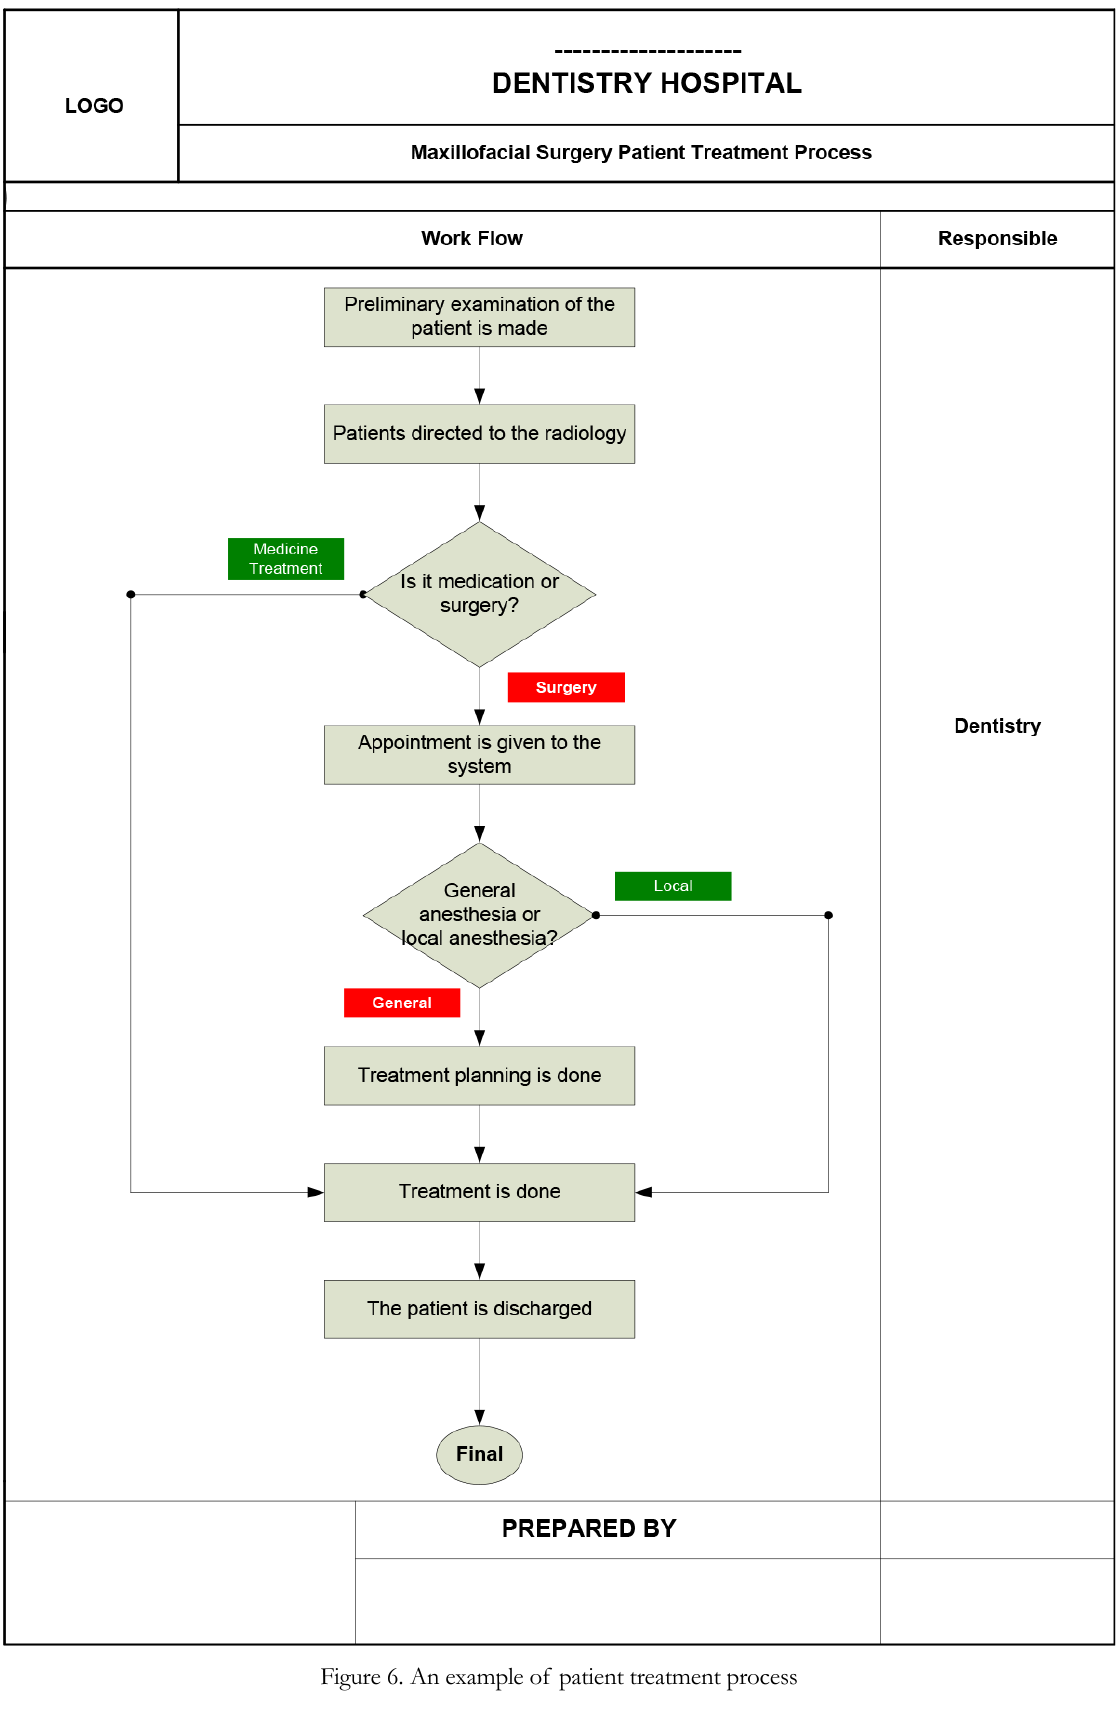
Figure 6. An example of patient treatment